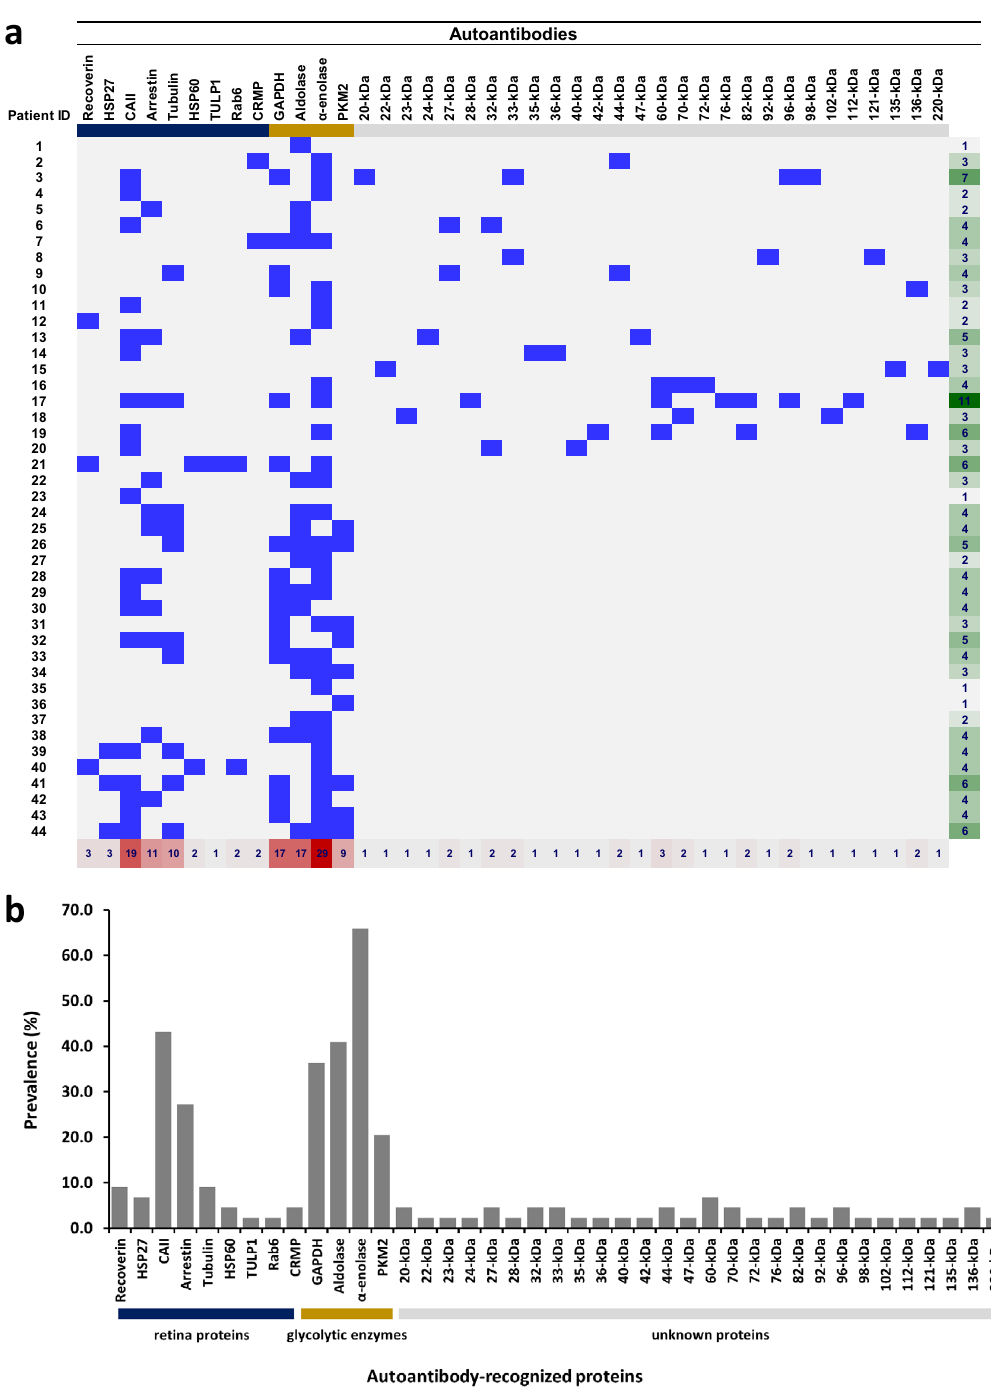
Figure 2. (a) Autoantibody profile in patients. The antibody array depicts the positive autoantibodies against the corresponding proteins (blue boxes), negative results are shown as grey boxes and white boxes indicate that the test was not assigned. The colored line under the antibody names described the retina proteins (dark blue), glycolytic enzymes (yellow), and unidentified retina proteins (grey). The last column on the right describes the total number of antibodies in each patient (green gradient) and the lowest row shows the number of patients having each type of antibody (red gradient). (b) Prevalence of autoantibodies in 44 patients. Bar chart depicts the prevalence of the autoantibodies based on the three protein panels: retina proteins (dark blue), glycolytic enzyme (yellow), and unidentified retina proteins (grey). HSP heat shock protein, CAII carbonic anhydrase II, TULP1 tubby-like protein 1, CRMP collapsin response mediator protein, GAPDH glyceraldehyde 3-phosphate dehydrogenase, PKM2 pyruvate kinase isozyme M2, kDa kilo